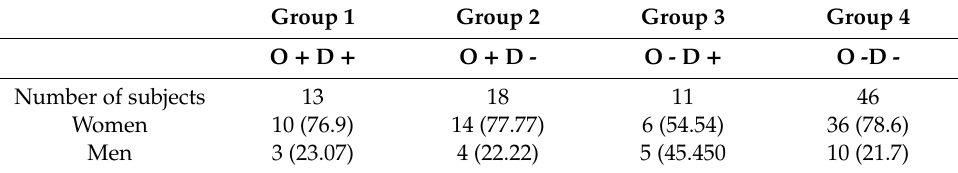
Table 2. Distribution of subjects depending on the presence of diabetes and